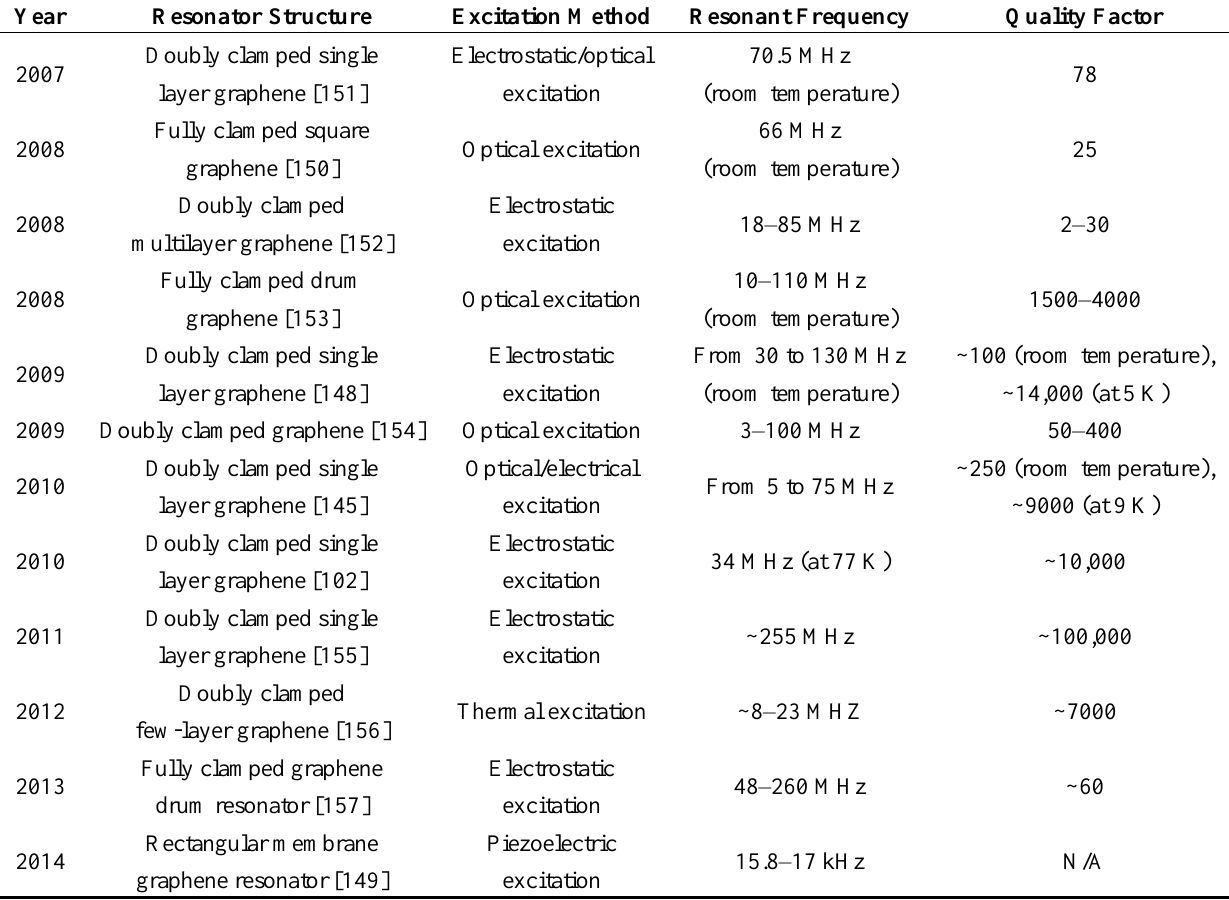
Table 3. Comparison of some graphene mechanical resonators reported during the past several